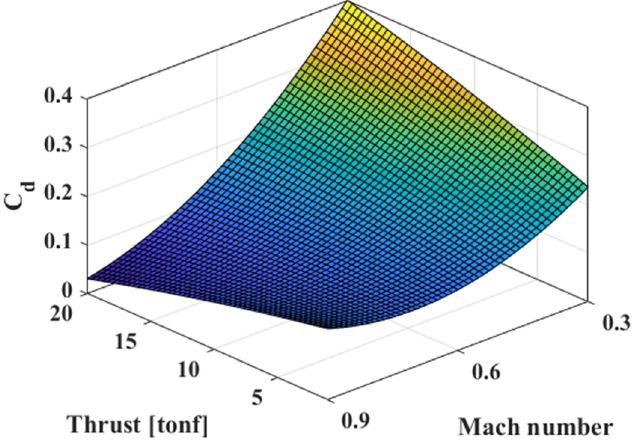
Figure 12. Cd prediction using different Mach numbers and thrust values.